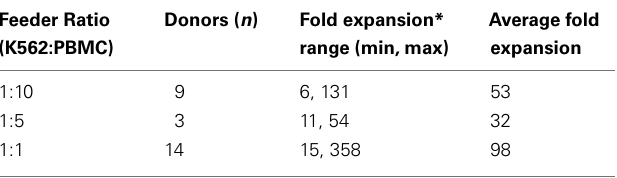
Table 6 | Optimization of ratio of feeder cells: K562 to PBMC.